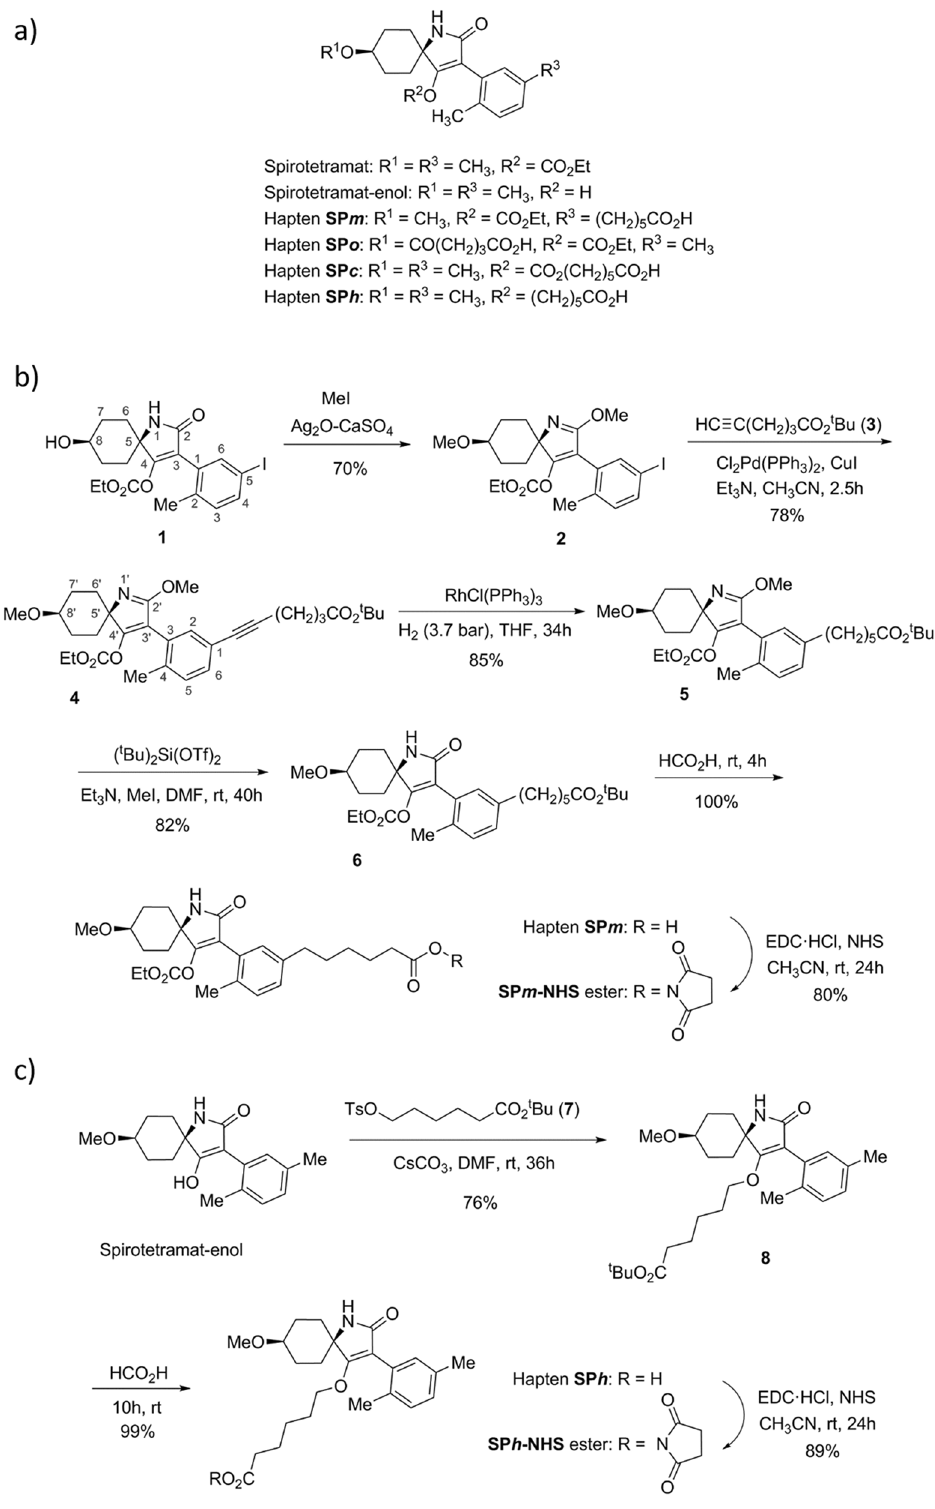
Figure 1 . ( a ) Chemical structures of SP, SP-enol, and the four synthetic haptens. ( b ) Synthesis and activation of hapten SP m . ( c ) Synthesis and activation of hapten SP h